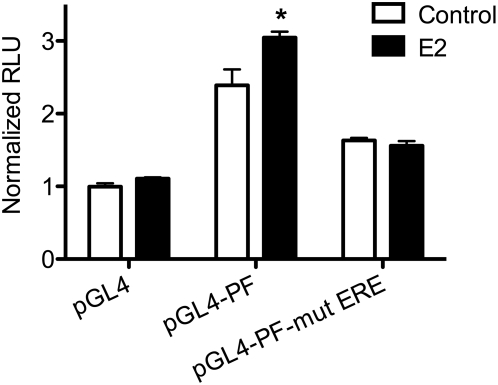
Estradiol induction of ERα promoter activity is mediated by a half ERE site.RAW 264.7 cells were transiently transfected with the pGL4 luciferase expression vector containing either the wild-type ERα promoter F (pGL4-PF) or the half ERE mutated promoter F (pGL4-PF-mut ERE). Cells were treated with 10−7 M E2 for 48 hrs and then analyzed for luciferase activity. Results are expressed in relative light units normalized to vehicle-treated empty vector and are representative of at least three independent transfections. *p<0.05 vs. vehicle control.